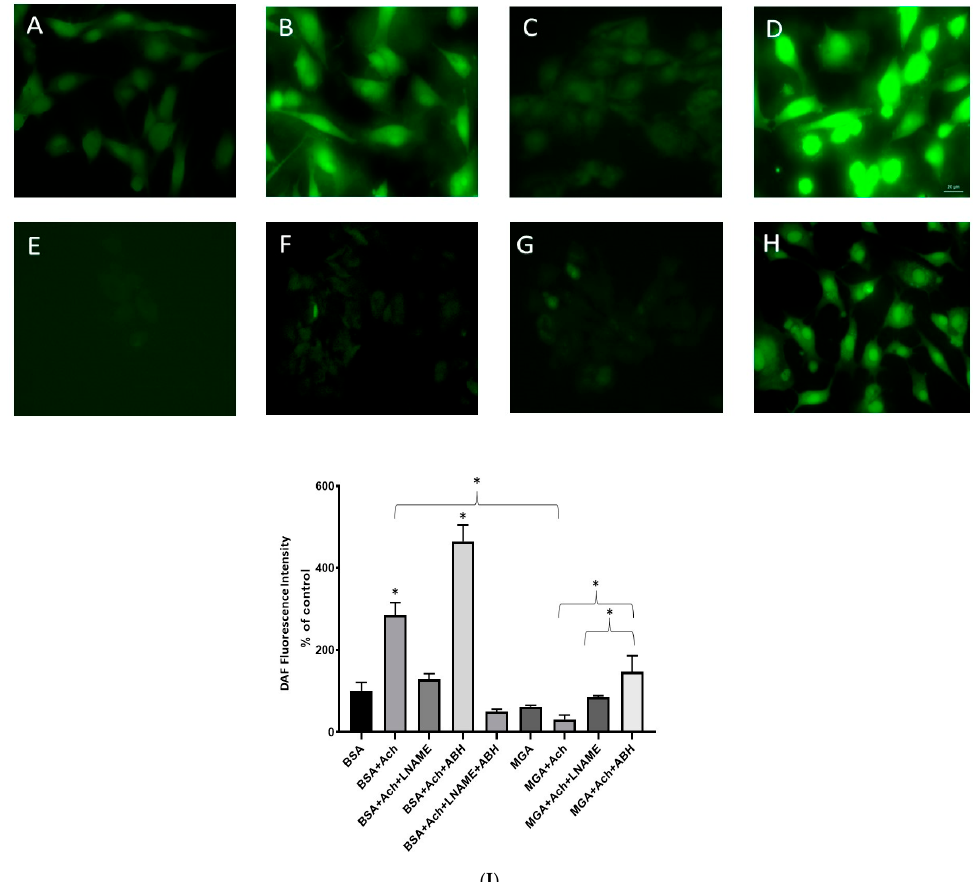
Figure 3. Fluorescent microscopy images of fixed MAECs in 2% formaldehyde after incubation with DAF-2DA (5 µM, 40 min). All cells were pretreated with either BSA (100 µM, 24 h) in ( A – D ), or MGA (100 µM, 24 h) in ( E – H ). Panels of different cells treatments are as follows: ( A ) BSA without ACh induction, ( B ) BSA with ACh induction, ( C ) BSA with ACh induction and pretreated with L- NAME, ( D ) BSA with ACh induction and pretreated with ABH, ( E ) MGA without ACh induction, ( F ) MGA with ACh induction, ( G ) MGA with ACh induction and pretreated with L-NAME, ( H ) MGA with ACh induction and pretreated with ABH. Bar: 20 µm. Fluorescence reflects NO produc- tion, which was more intense in cells induced with acetylcholine than in cells without acetylcholine. MGA-treated cells had lower fluorescence, indicating lower NO production even with acetylcholine induction ( F ); however, when pretreated with ABH ( H ), fluorescence induced by ACh was intensi- fied and NO was restored to a level higher than ACh-induced, MG-treated cells ( F ). L-NAME inhib- itor abolished ACh-induced fluorescence, reflecting inhibition of eNOS activity and NO production. A quantification of DAF fluorescence intensity in the different treatment conditions is demonstrated in ( I ). Values are expressed as percentage of BSA (control); analyzed images were obtained from 3 independent experiments. * p < 0.05. ACh, acetylcholine (1 µM); L-NAME, N (G)-nitro-L-arginine methyl ester (1 µM); ABH, boronic acids 2(S)-amino-6-boronohexanoic acid (1 mM). 3.4. Vascular Function